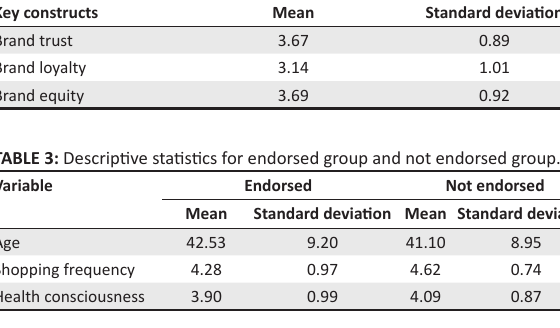
TABLE 2: Descriptive statistics for brand trust, brand loyalty and brand equity. Key constructs Brand loyalty